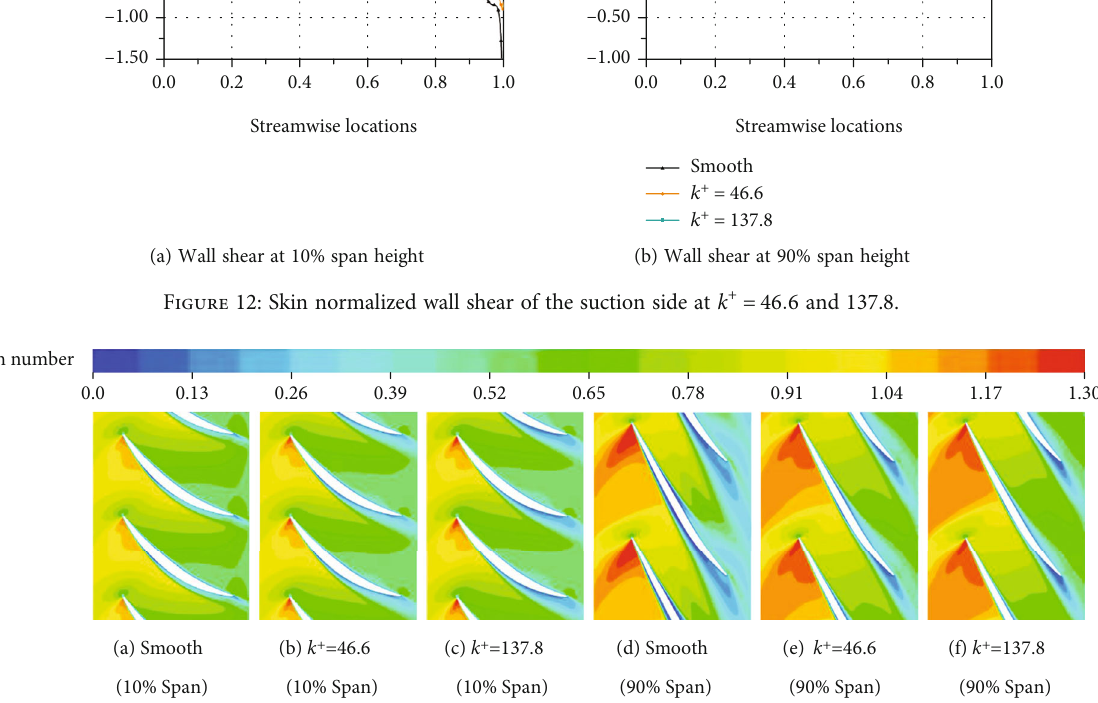
Figure 13: Relative Mach number contour versus k + at di ff erent span